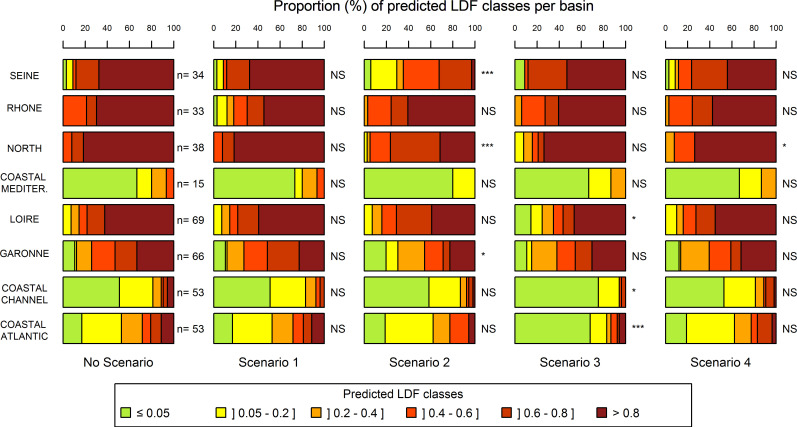
Proportions of LDF classes per basin for each scenario.The colors correspond to the LDF classes calculated without any scenario (No Scenario), after removing barriers over 10 m in height (Scenario 1), after removing barriers between 2 m and 10 m in height (Scenario 2), after removing barriers under 2 m in height (Scenario 3) and after reducing local hydrological, morphological and water quality alterations (Scenario 4). P-values significant at a 5% level (*), 1% (**), 0.1% (***) and not significant (NS) are provided. ‘n’ corresponds to the number of sites in each basin.